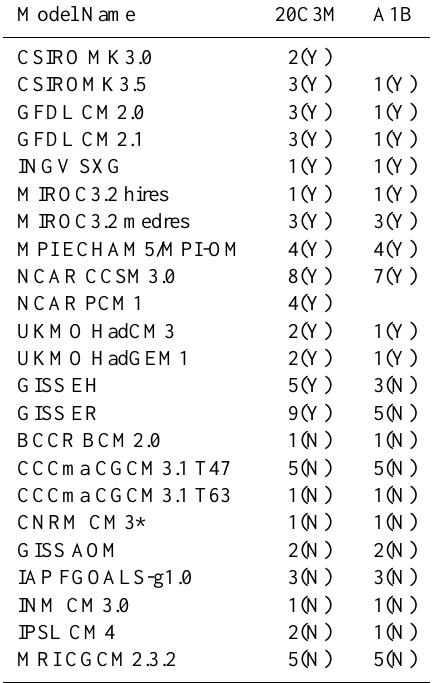
Table 1. IPCC-AR4 models used in this study. “Y” and “N” in brackets denote the model has or has not prescribed ozone recovery, respectively. Numbers indicate ensemble numbers of simulations.